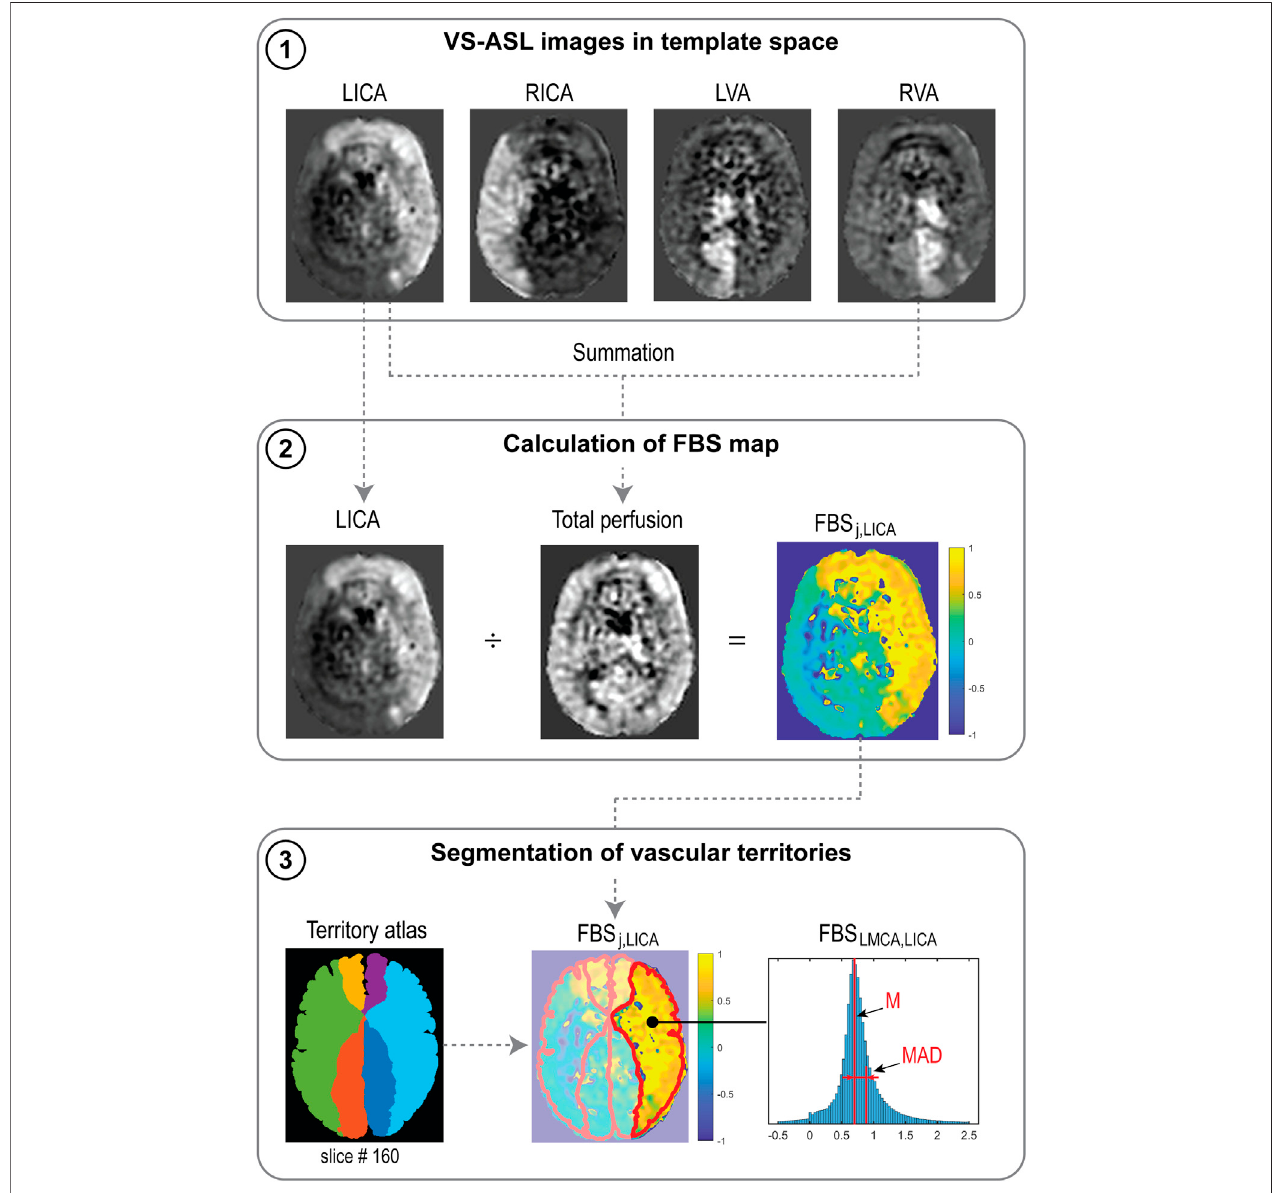
FIGURE 3 | Processes to calculate FBS j,k from VS-ASL images, illustrated for the LICA. (1) Scaled VS-ASL perfusion images in standardized template space. (2) Calculation ofspatial FBS j,k maps. (3)Segmentation ofterritories using a vascular territory atlas and calculation ofmedian (M) and median absolute deviation (MAD) from the FBS j,k distribution in each